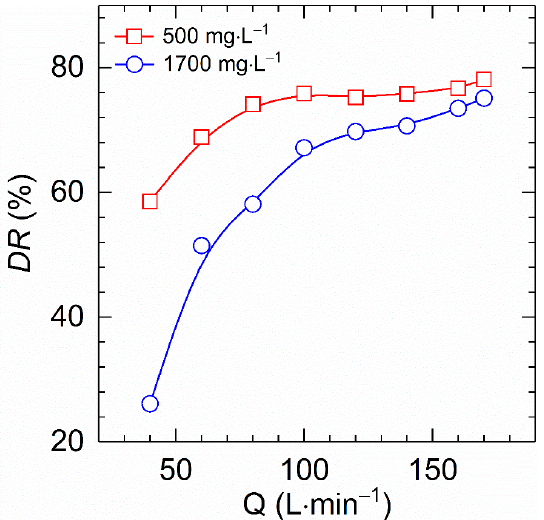
Figure 9. The dependence of drag reduction and apparent viscosity on polymer concentration (T, 30 ° C; shear rate, 170 s − 1 ; flux, 170 L ⋅ min − 1 ).